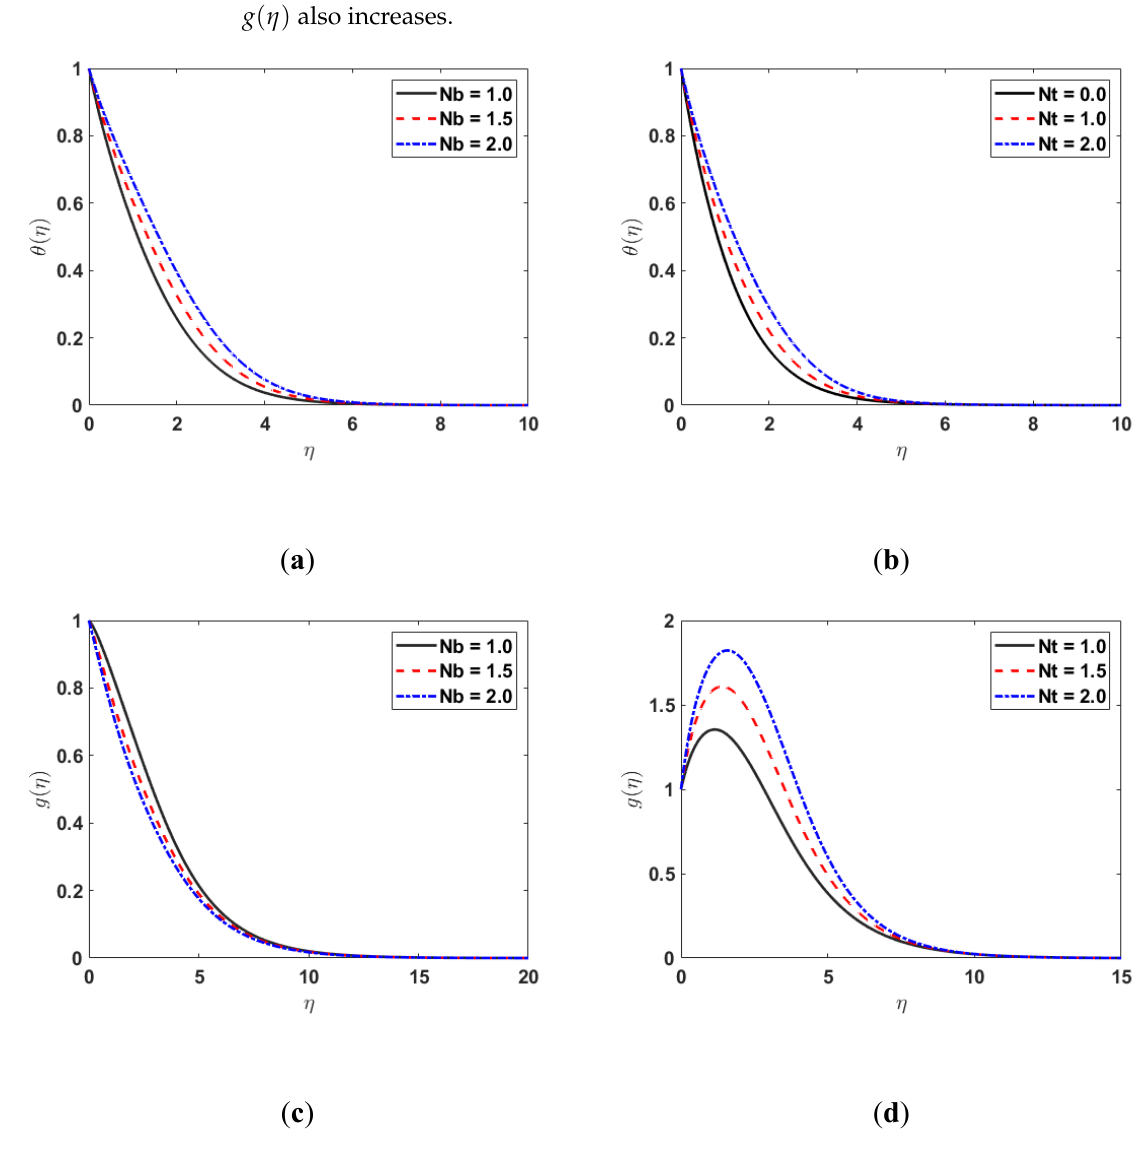
Figure 5. ( a ) 𝜃(cid:4666)𝜂(cid:4667) along 𝑁𝑏 ; ( b ) 𝜃(cid:4666)𝜂(cid:4667) along 𝑁𝑡 ; ( c ) 𝑔(cid:4666)𝜂(cid:4667) along 𝑁𝑏 ; ( d ) 𝑔(cid:4666)𝜂(cid:4667) along 𝑁𝑡 . Figure 5. ( a ) θ ( η ) along Nb ; ( b ) θ ( η ) along Nt ; ( c ) g ( η ) along Nb ; ( d ) g ( η ) along Nt